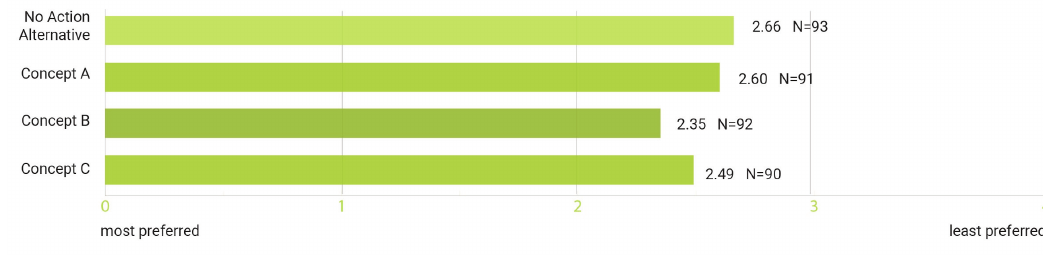
Figure 14. Overall comparative ranking of design concepts.